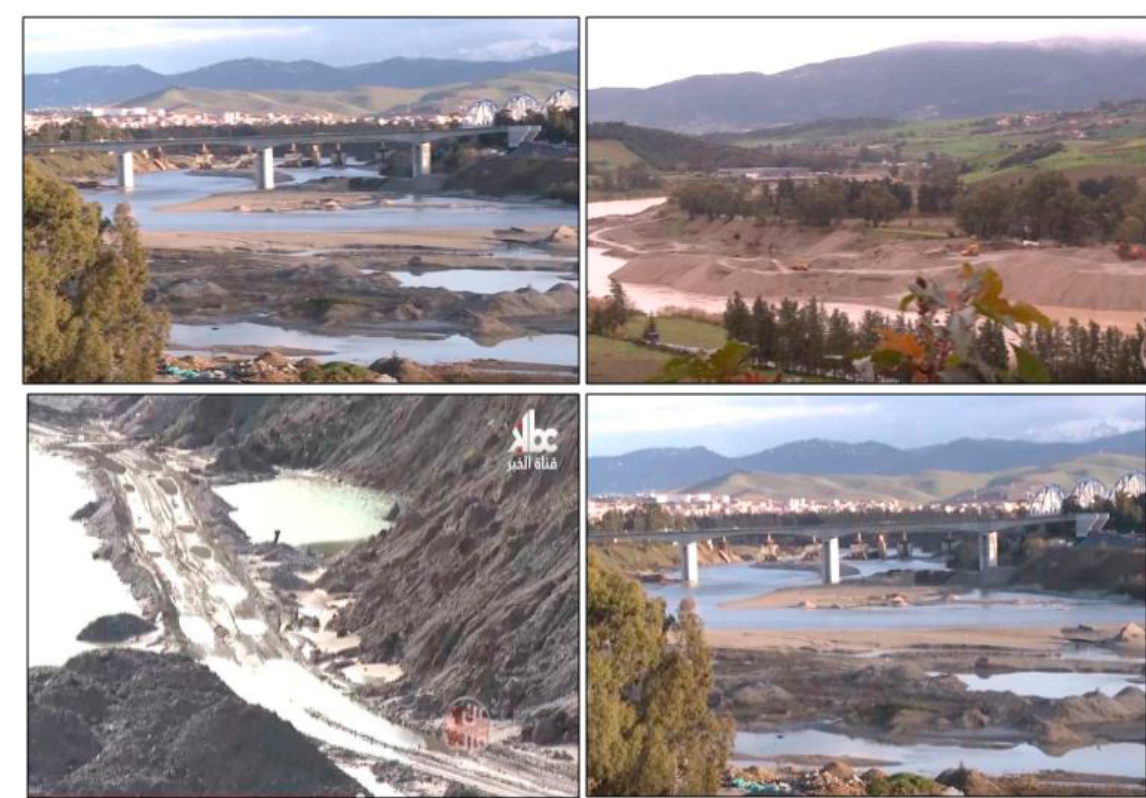
Figure 11. Some pictures regarding the impacts and modifications of anthropological activities due to the extraction of large amounts of sand and rock from the riverbed of the Sebaou River.